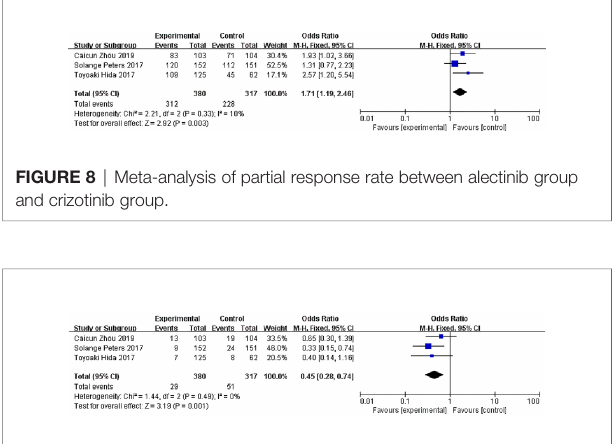
FIGURE 6 | Meta-analysis of disease control rate between the alectinib group the crizotinib group.